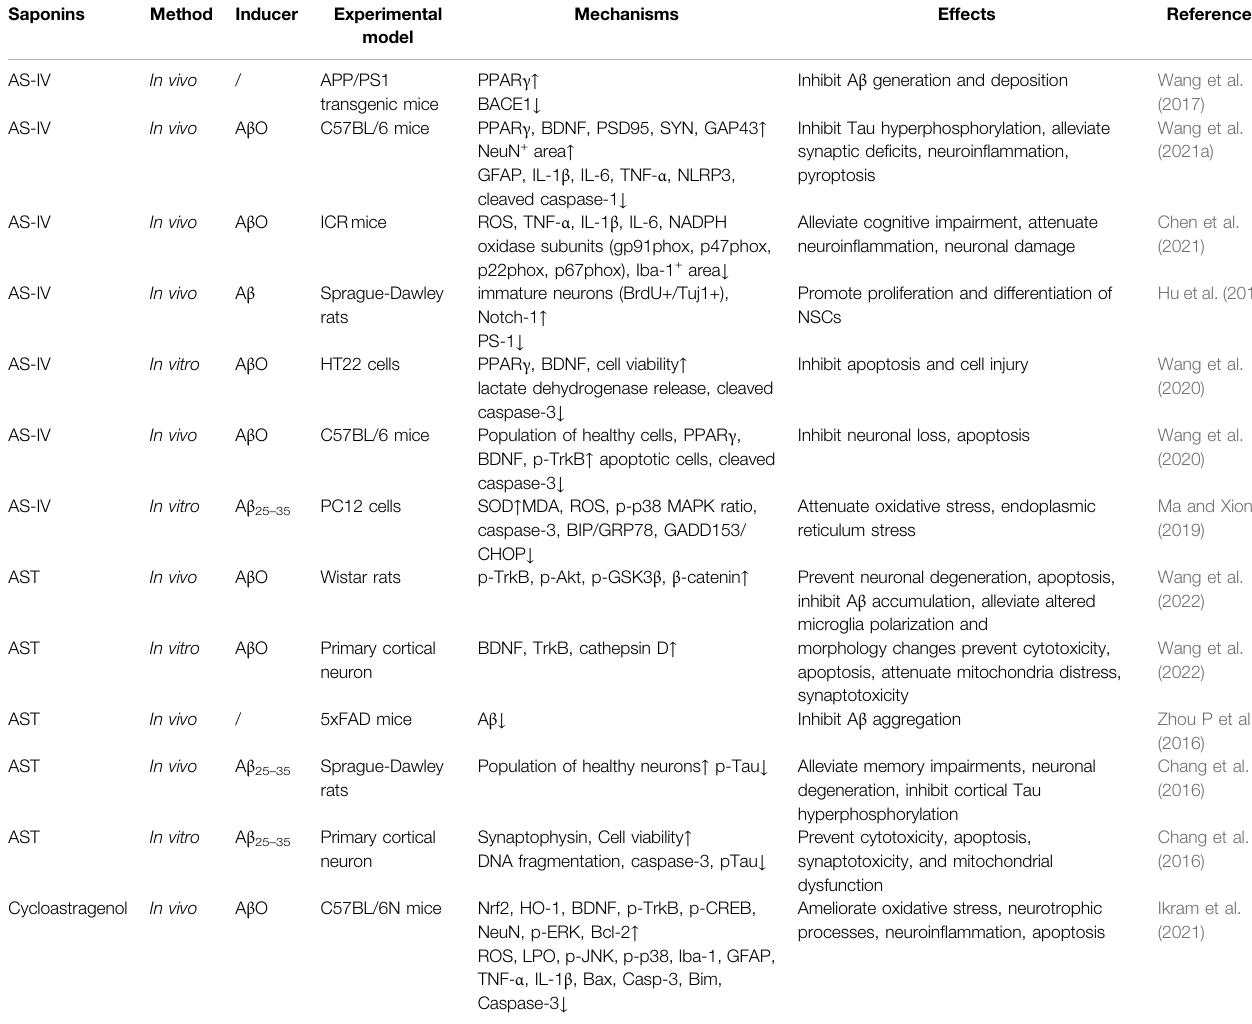
TABLE 1 | The effect and mechanisms of saponins from Astragali radix against Alzheimer ’ s disease. Saponins Method